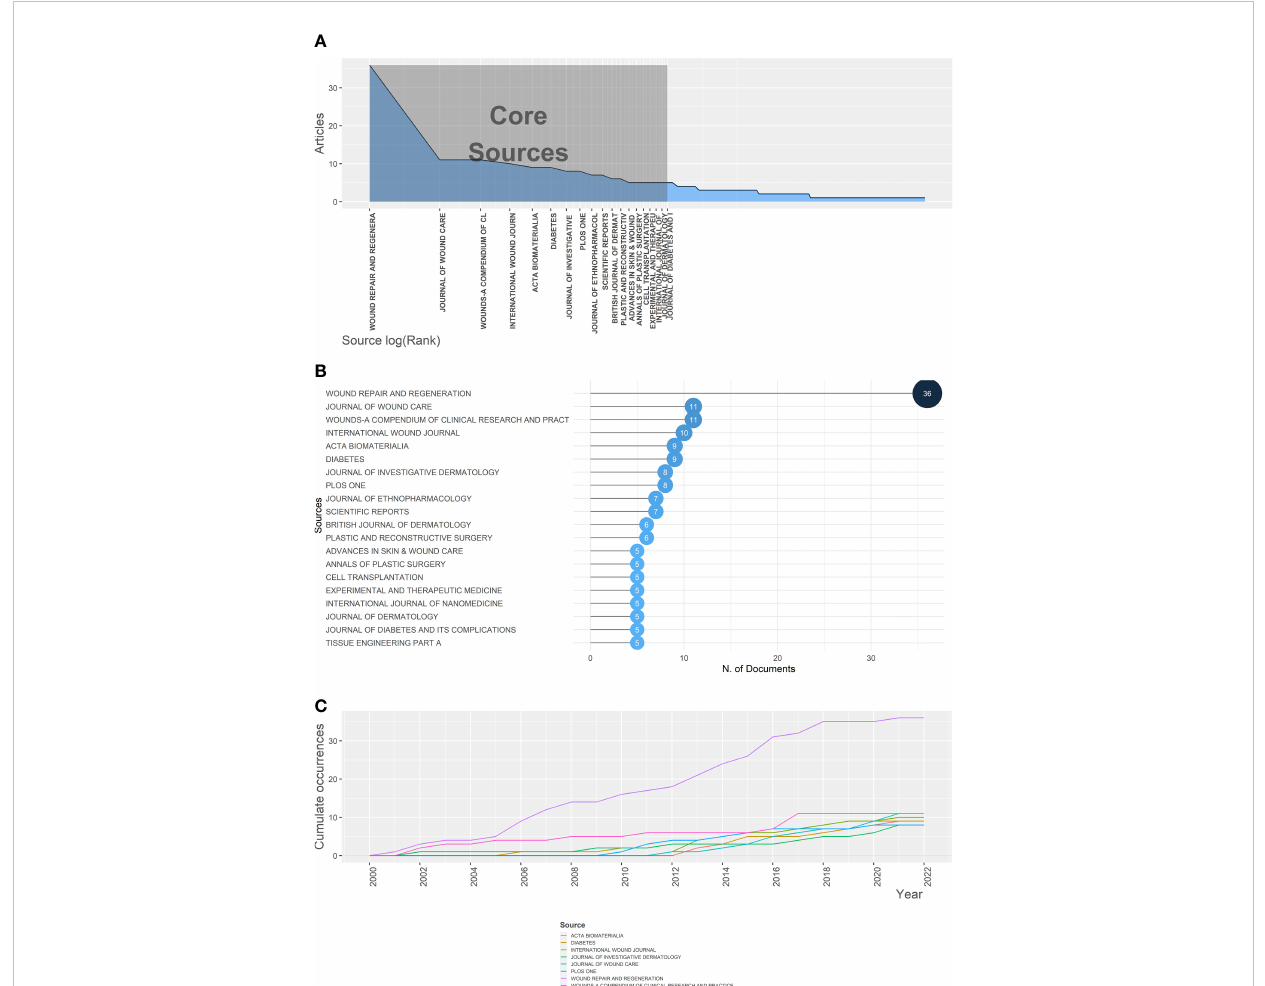
FIGURE 2 The Journal of Wound Repair and Regeneration was a critical pathway to access the research frontiers and crucial information of fi broblast-related DFUs research. (A) Core journals of fi broblast-related DFUs research based on Bradford ’ s Law. (B) The top 20 journals on fi broblast-related DFUs research with the highest number of publications. (C) The six highest yielding journals growth of fi broblast-related DFUs research from 2000 to